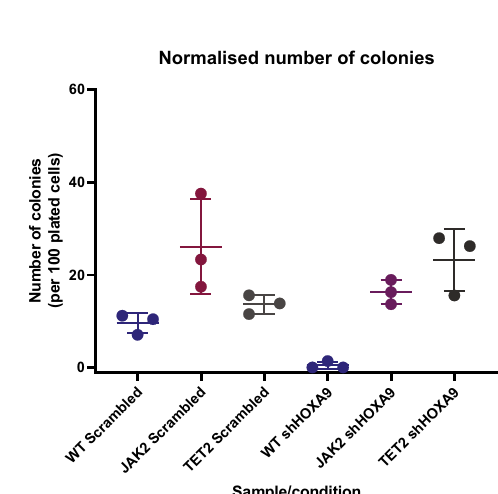
Fig. 4 | JAK2 activation of HOXA9 improves colony survival in response to HOXA9 inhibition. a The ratios of colonies produced per sample are expressed as Scrambled:shHOXA9 colony number ratio with means. b The normalised colony count per sample and per condition with means and interquartile ranges of the three replicates. Two-wayANOVAstatistical tests using multiple comparisons with